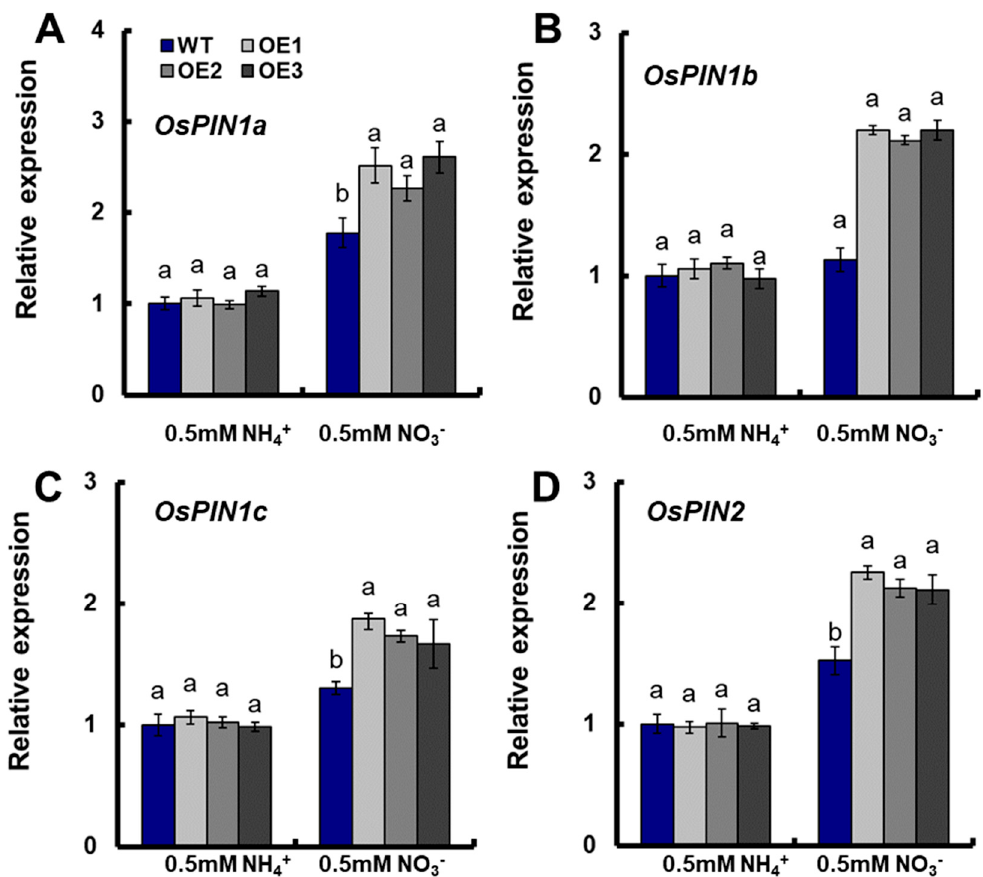
Figure 4. The expressions of OsPINs in the roots of WT and OsNRT2.1 transgenic lines under 0.5-mM NH 4 + or 0.5 mM NO 3 − conditions. WT and transgenic plants on the 10th day were shown in Figure 3. Real-time quantitative RT-PCR analysis of the expressions of ( A ) OsPIN1a, ( B ) OsPIN1b, ( C ) OsPIN1c, and ( D ) OsPIN2 in WT and OsNRT2.1 transgenic lines. RNA was extracted from roots. Error bars: SE ( n = 5). Significant differences between transgenic lines and WT are indicated by different letters ( p < 0.05, one-way ANOVA).